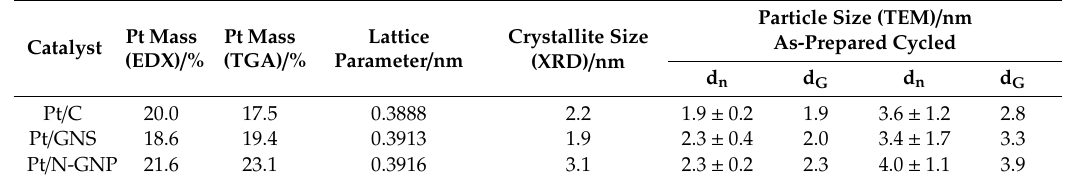
Table 1. Pt mass by Dispersive Energy (EDX) and thermogravimetric analysis (TGA) measurements, Pt lattice parameter and crystallite size by XRD analysis, and Pt particle size by Transmission Electronic Microscopy (TEM) micrographs of Pt / C, Pt / GNS, and Pt / N-GNP(d n : number averaged particle size and d G : average Gaussian Pt particle size).